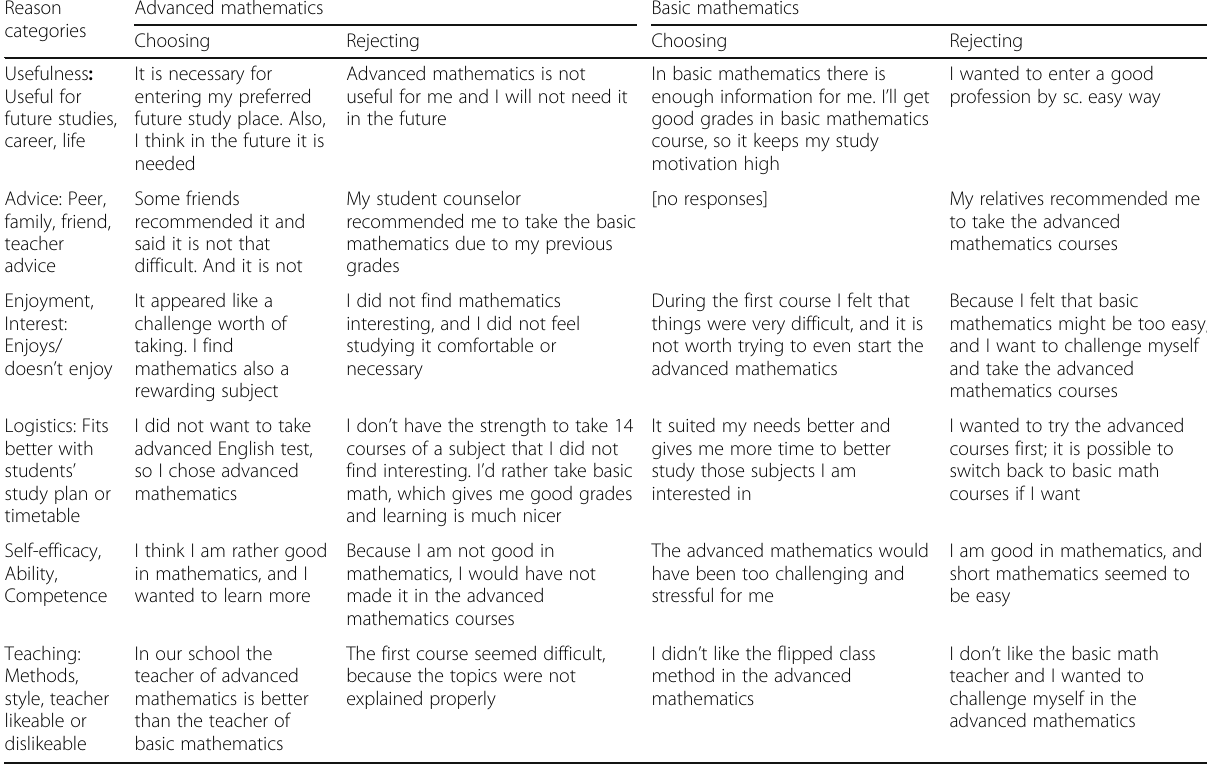
Table 1 Examples of students ’ reasons for choosing or rejecting